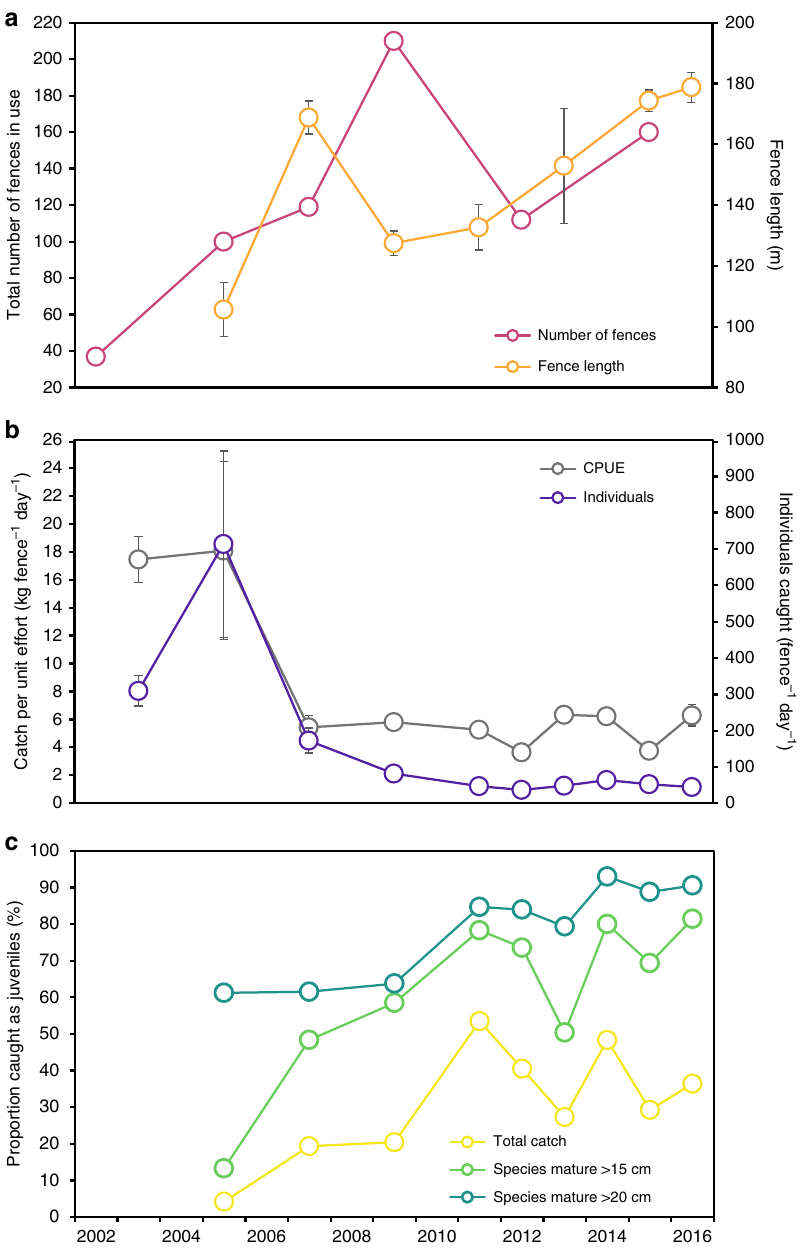
Fig. 3 a Total fi sh fence effort around Kaledupa Island between 2002 and 2016, showing total number of fi sh fences in use (pink), and length of fences measured along the central spine (orange). b Catch statistics from fi sh fences between 2003 and 2016 during intensive 5-week study periods July – August, showing catch per unit effort (CPUE; grey) and number of individual fi sh caught (purple). c Overall proportion of fi sh caught as juveniles for the total catch (all species combined; yellow), for species that mature above 15 cm (green) and for species that mature above 20 cm (blue). Data shown in a and b are mean ± 1 standard error (SE) where applicable. For n of fences and catches surveyed at each time point see Supplementary Table